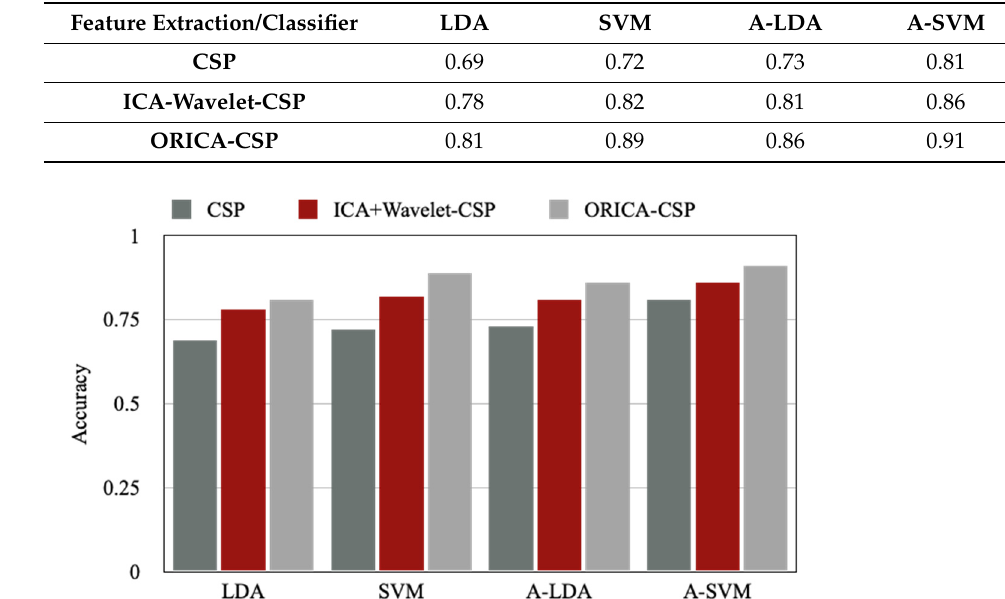
Table 5. The average classification accuracy of several feature extraction techniques is compared.